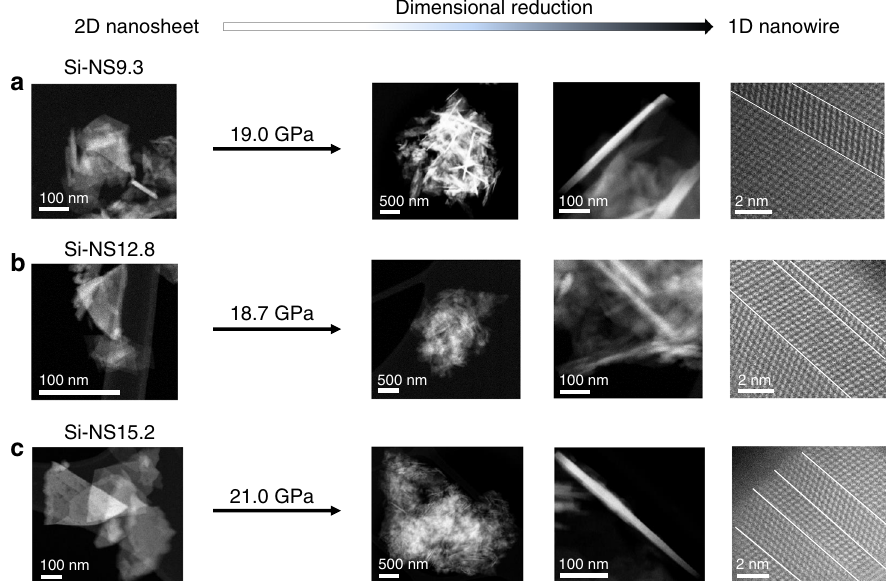
Fig. 4 HAADF-STEM images of Si-nanowires formed from Si-nanosheets. 2D-Si-nanosheets of different crystallite sizes are seen on the left. a Si-NS9.3. b Si-NS12.8. c Si-NS15.2 Increasing magni fi cation HAADF-STEM images of nanowires found in X-ray amorphous materials subsequent to high-pressure and complete decompression. White lines are the twinning planes {111} for Si. The 2D Si-nanosheets transformed to 1D Si-nanowires during decompression at room